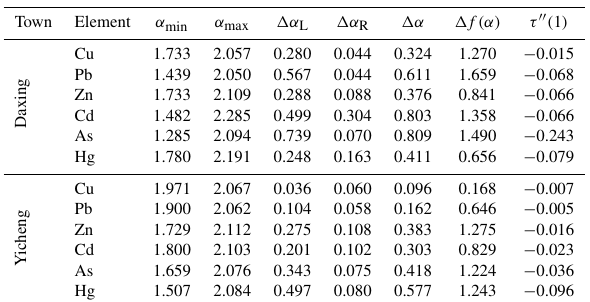
Table 2. Multifractal parameters of the elements analysed during this